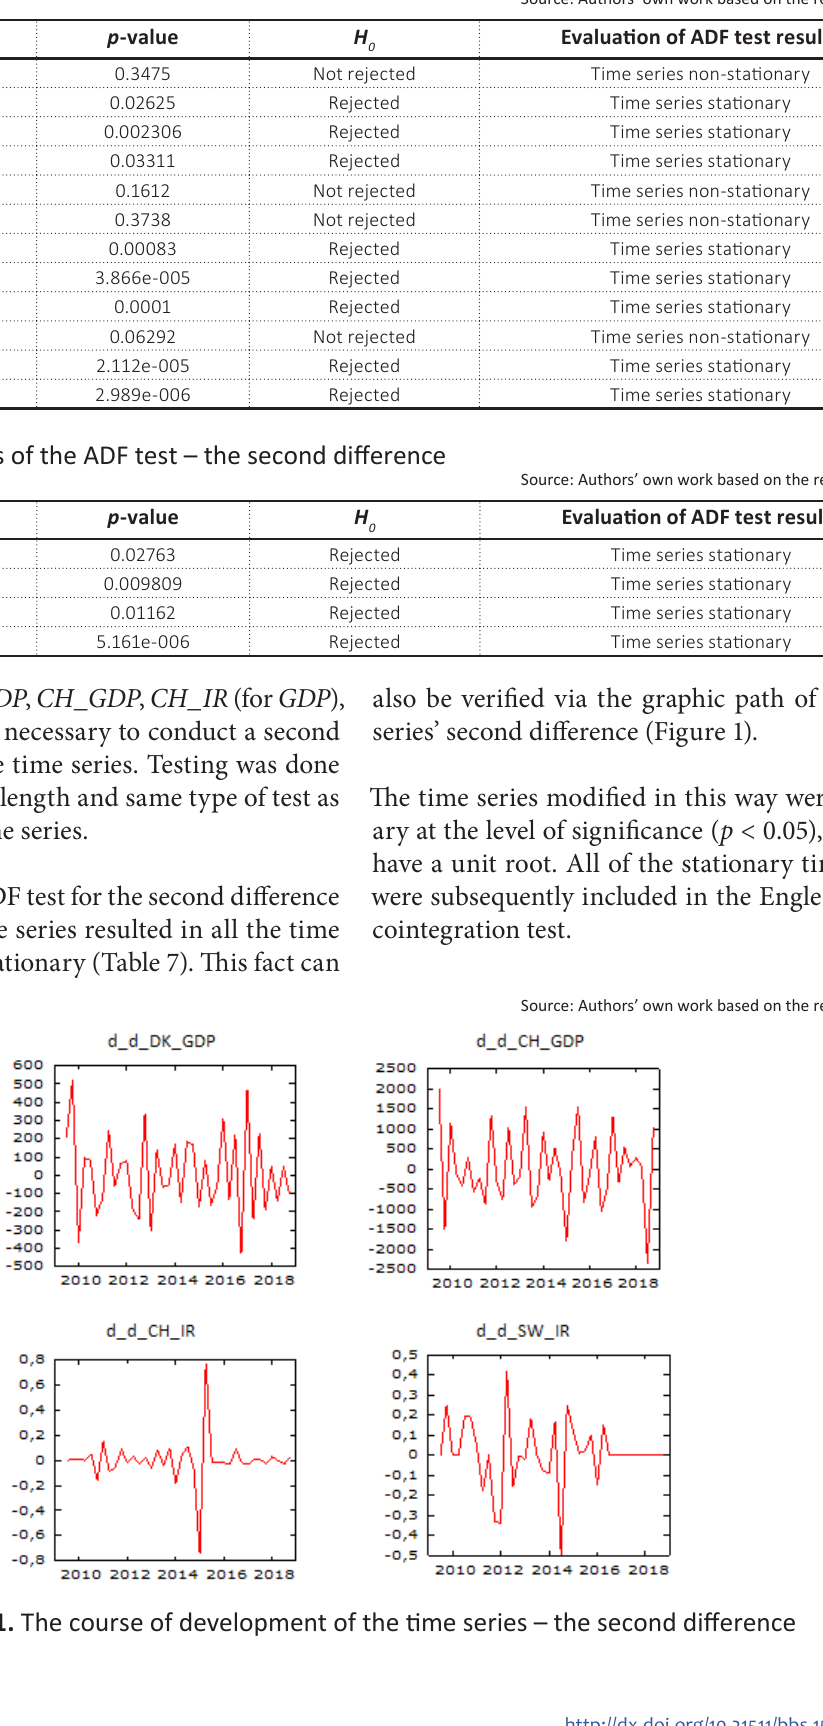
Table 6. The results of the ADF test – the first difference